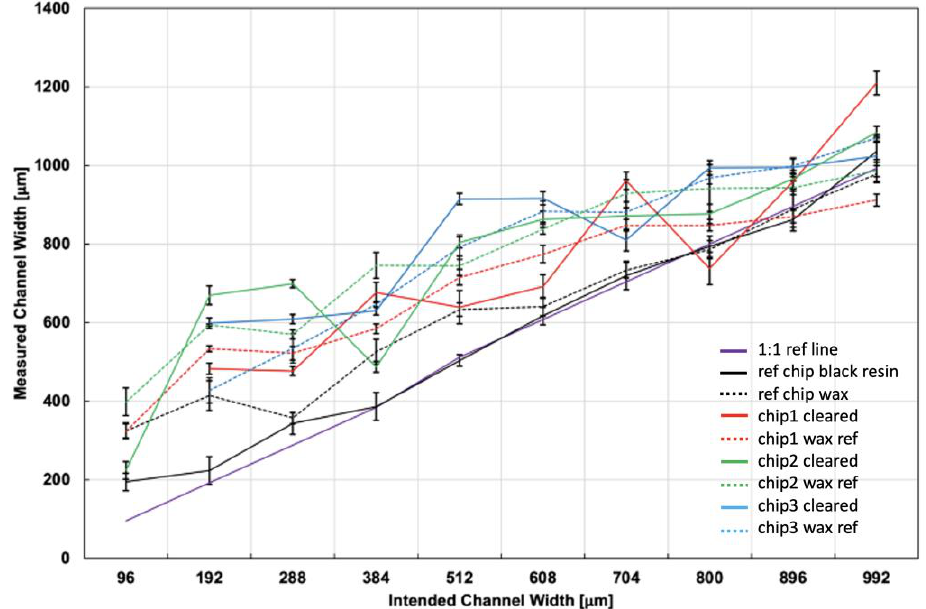
Figure 2. 3D-print fidelity and reproducibility. Channels with square cross-section were 3D-printed in wax and in black resin, both inside bulk transparent resin. The printed physical size of each channel was measured optically at five locations. The five measurements produced an average and standard deviation, which were plotted against intended width. The results suggest high reproducibility but low fidelity for cleared flow channels and wax reference channels, particularly at the smaller dimensions, and high fidelity for black resin channels.